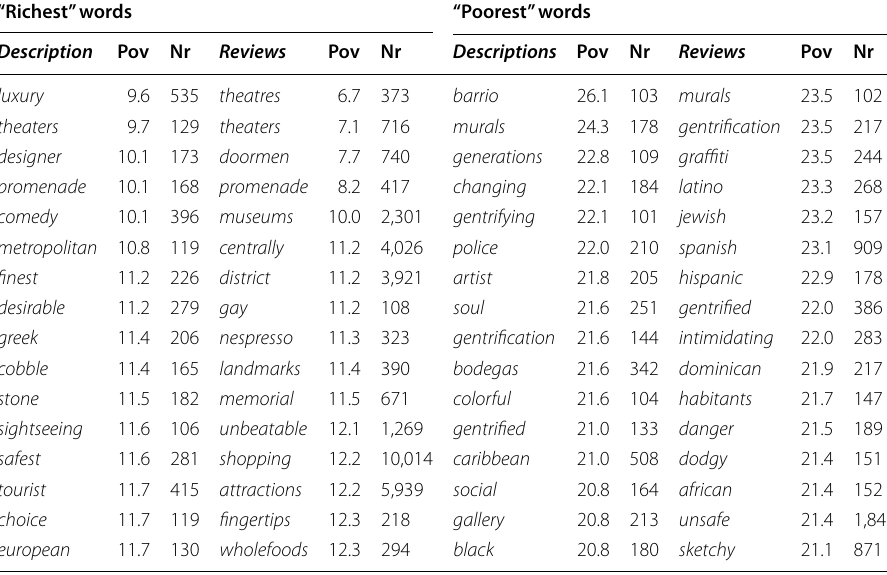
Table 1 This table lists the words used in the listing neighborhood description sorted by the words’ “poverty”, defined as the average share of the households living in poverty in the neighborhood, according to the ACS definition, in which the word is used over all word occurrences. Left half of this table shows the “richest” words, and the right half shows the “poorest” words. Place and person names were removed, and only words occurring more than 100 times are included. These are split between content appearing in hosts’ neighborhood descriptions, and in guest reviews. “Nr” shows the number of occurrences. “Pov” shows the average rate of households living below the poverty line in the neighborhoods where the word is